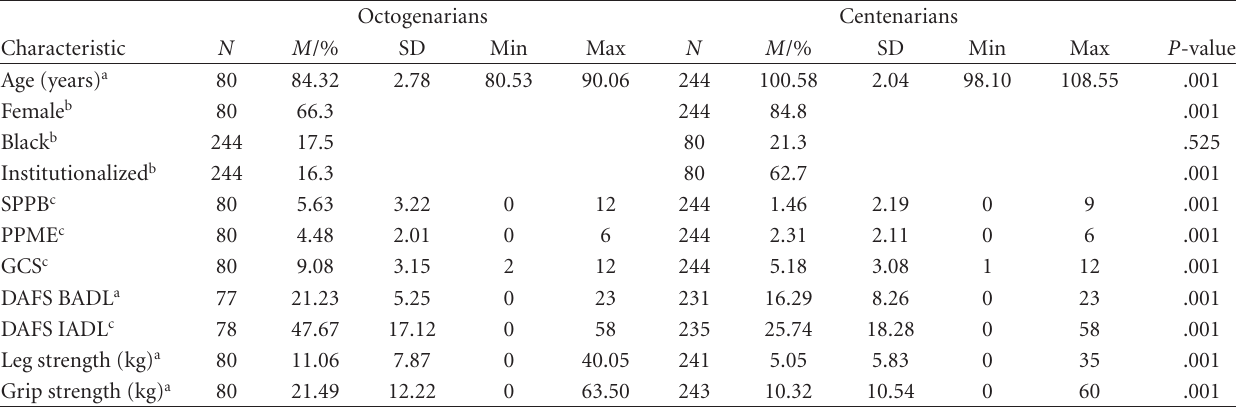
Table 1: Sample characteristics by age